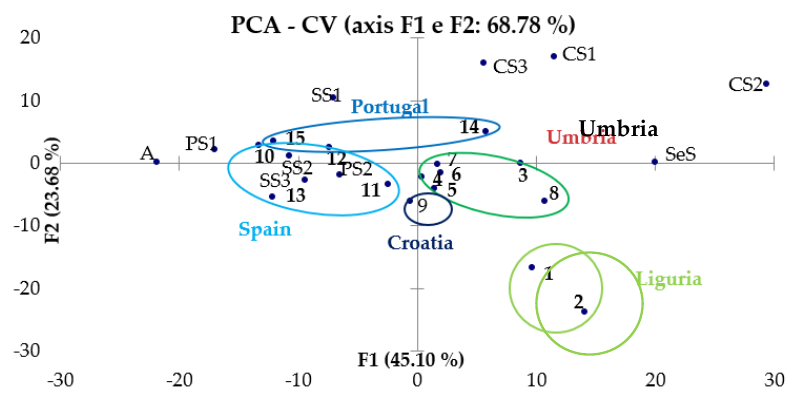
Figure 7. PCA of CV data.